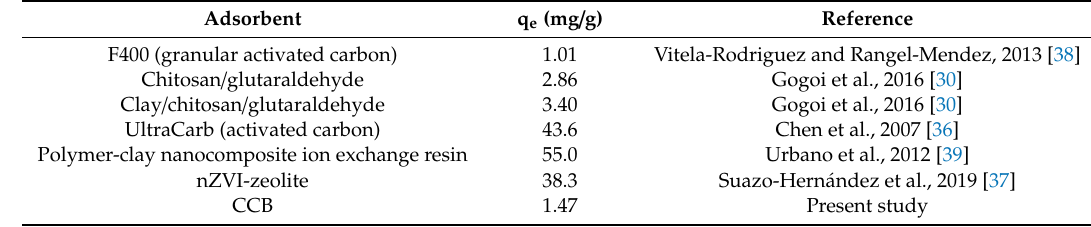
Table 4. Comparison of adsorbents utilized in the removal of As(V).